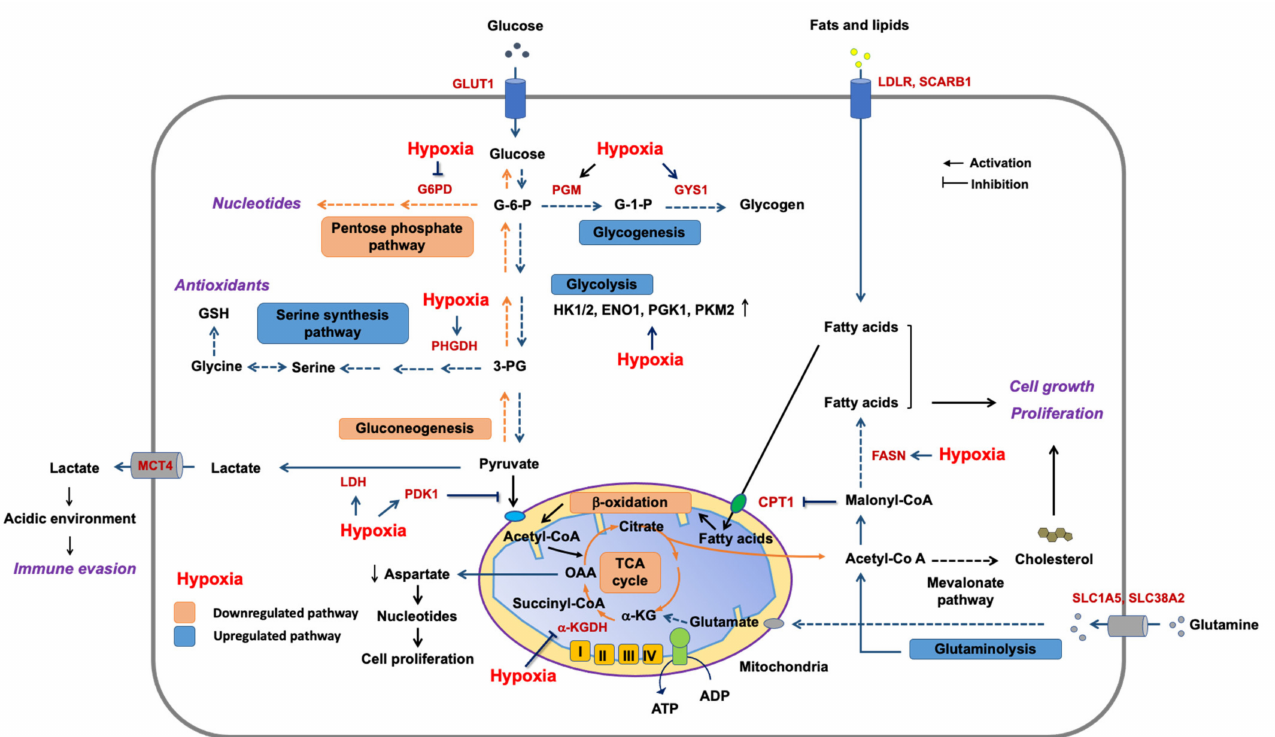
Figure 4. Metabolic adaptations to hypoxia. Glucose transporter1 (GLUT1), hexokinases1/2 (HK1 and HK2), enolase1 (ENO1), phosphoglycerate kinase1 (PGK1), pyruvate kinase (PKM2), pyruvate dehydrogenase kinase1 (PDK1), lactate dehydrogenase (LDHA), glutamine transporters (SLC1A5 and SLC38A2), α -ketoglutarate dehydrogenase ( α -KGDH), fatty acid synthase (FASN), glucose-6-phosphate dehydrogenase (G6PD), phosphoglycerate dehydrogenase (PHGDH), phosphoglucomutase1 (PGM1), glycogen synthase1 (GYS1), LDL receptor (LDLR), and HDL receptor (SCARB1). Glucose-6- phosphate (G-6-P), glucose-1-phosphate (G-1-P), 3-phosphoglycerate (3-PG), α -ketoglutarate ( α -KG), oxaloacetate (OAA), and glutathione